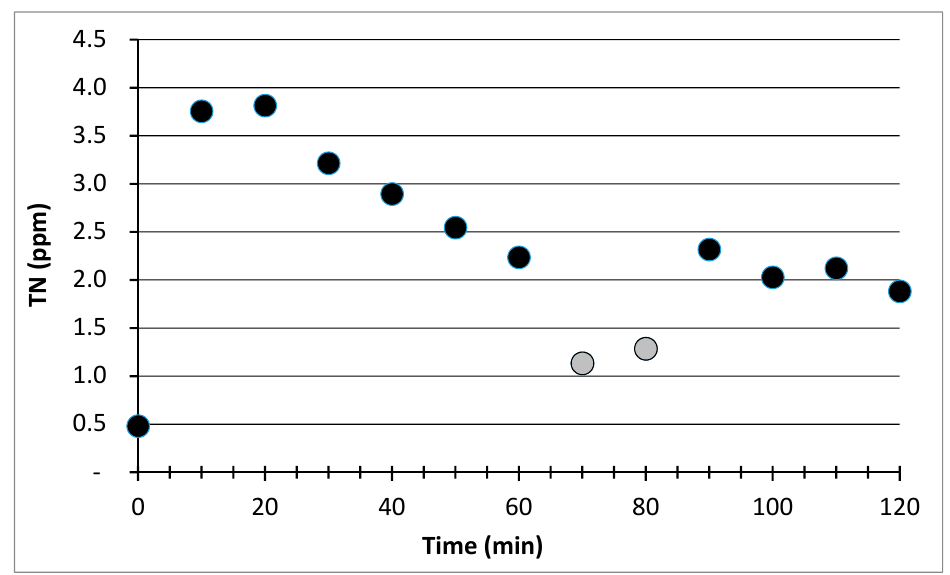
Figure 2. The relationship between total nitrogen (TN) concentration and irrigation time in the test run. A portion of the water from sample 8 and 9 (gray color dots) was directly collected from the irrigation water supply because the sprinkler near the sampling location failed.